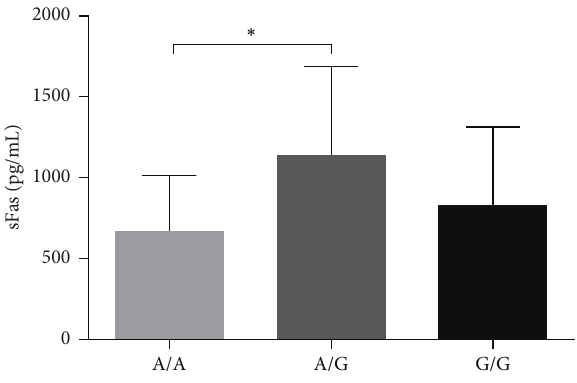
Figure 3: sFas concentration according to − 670 Fas genotype. The sFas concentrations in patients with the A/A and G/G genotypes were not significantly different. In contrast, the sFas concentration in patients with the A/G genotype was different compared to other genotypes. ∗ 𝑃 < 0.05